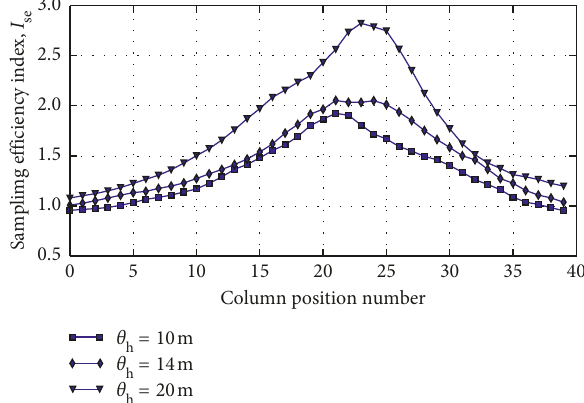
Figure 11: Uncertainty ratio for different values of θ sampling, 1st CPT fixed at i � 16), example